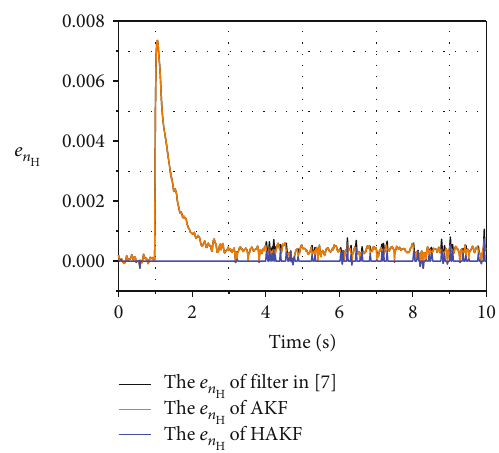
Figure 13: The estimated error e